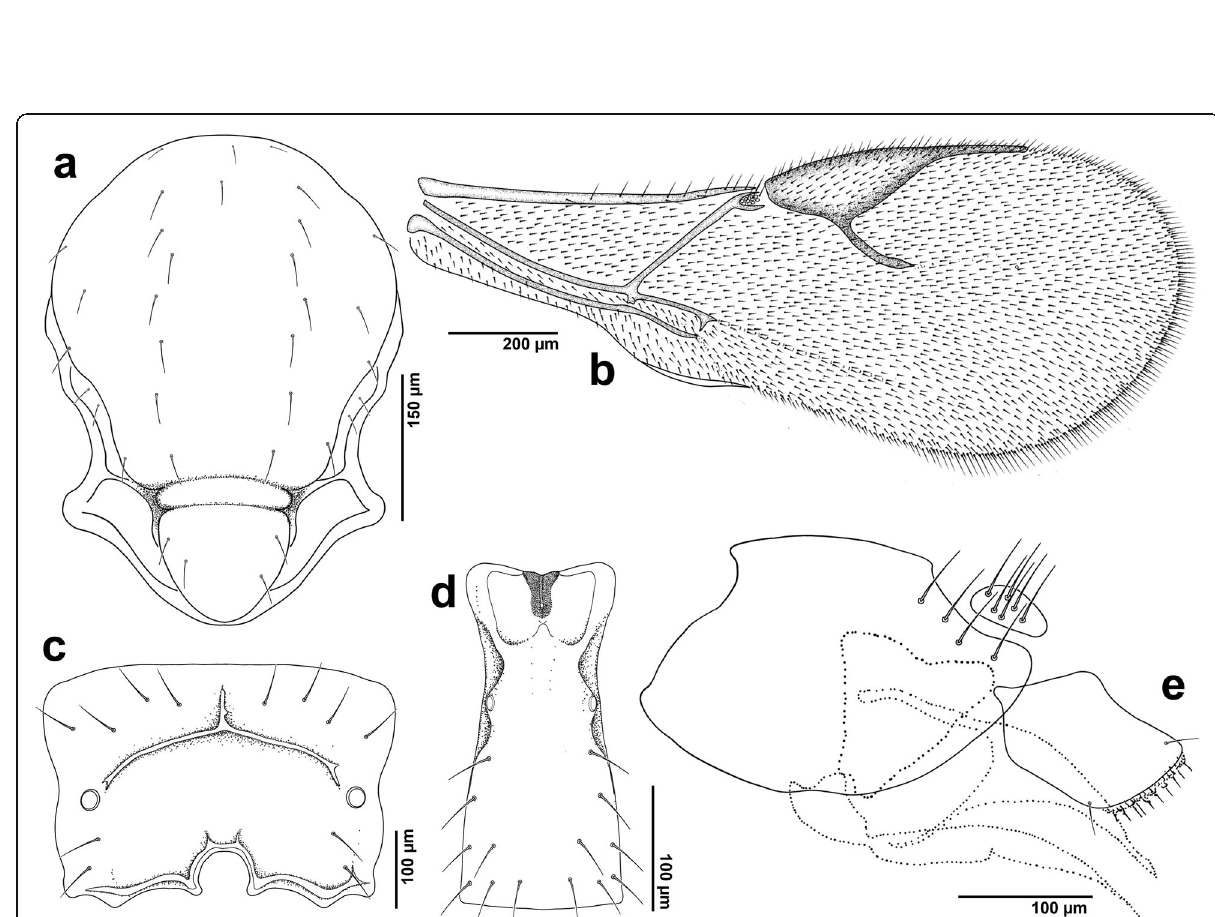
Fig. 2 Diaeretus leucopterus (Haliday), female. a Mesonotum, dorsal aspect. b Forewing. c Propodeum, dorsal aspect. d Petiole, dorsal aspect. e Genitalia, lateral aspect. (After Rakhshani et al.